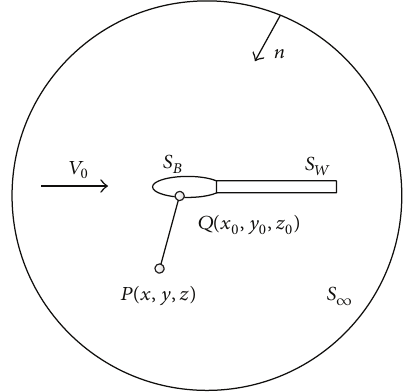
Figure 1: The schematic flow field of the wind wheel.